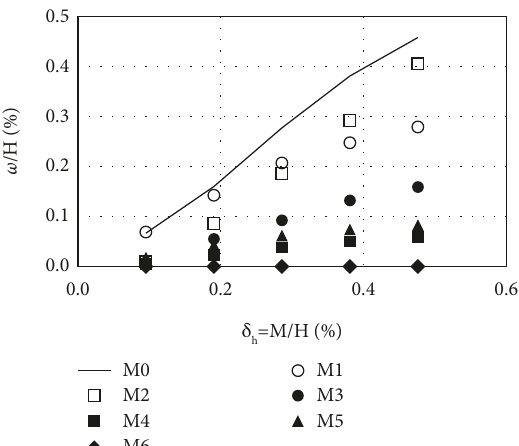
Figure 8: The relationship of the settlement ( ω ) at location P5 with the movement (M) of the retaining wall, and the settlement and the movement are normalized by the depth of retaining